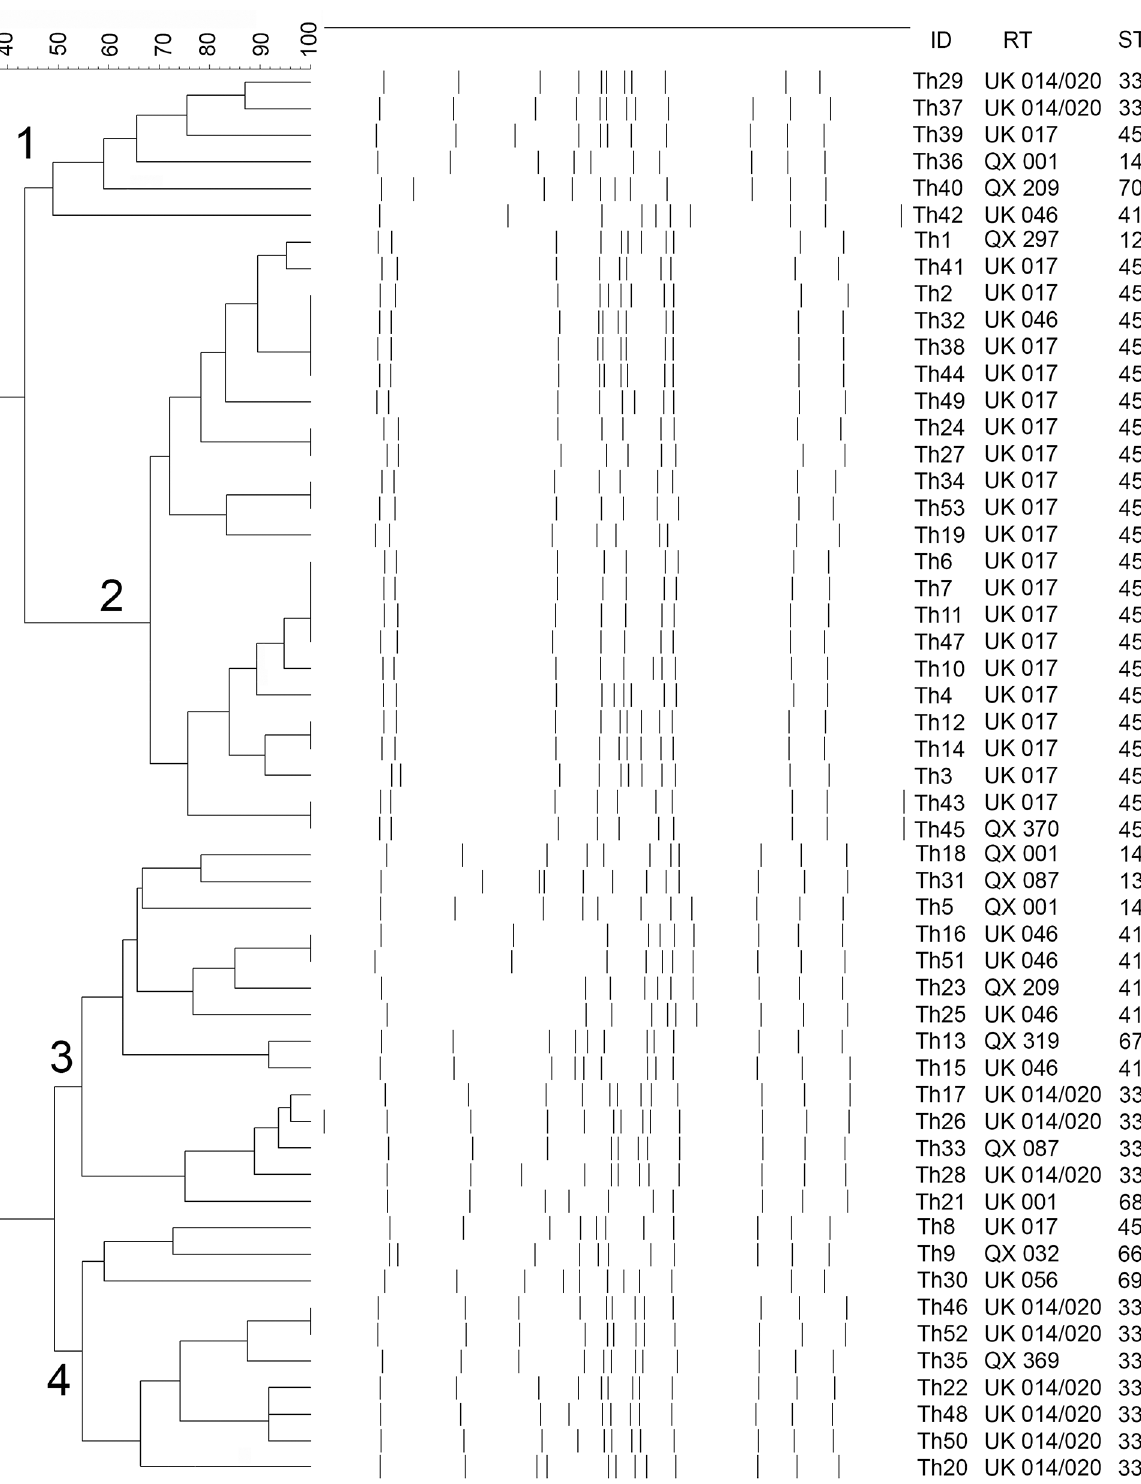
PLOS ONE | DOI:10.1371/journal.pone.0127026 May 22,